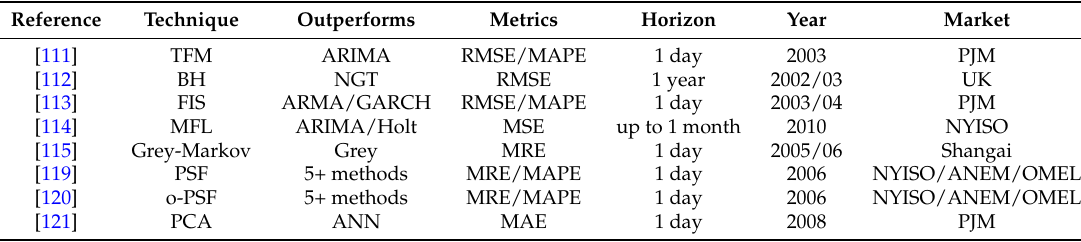
Table 8. Summary on other models for electricity